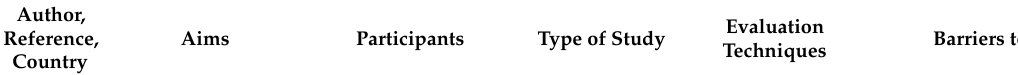
Table 1. Characteristics of the